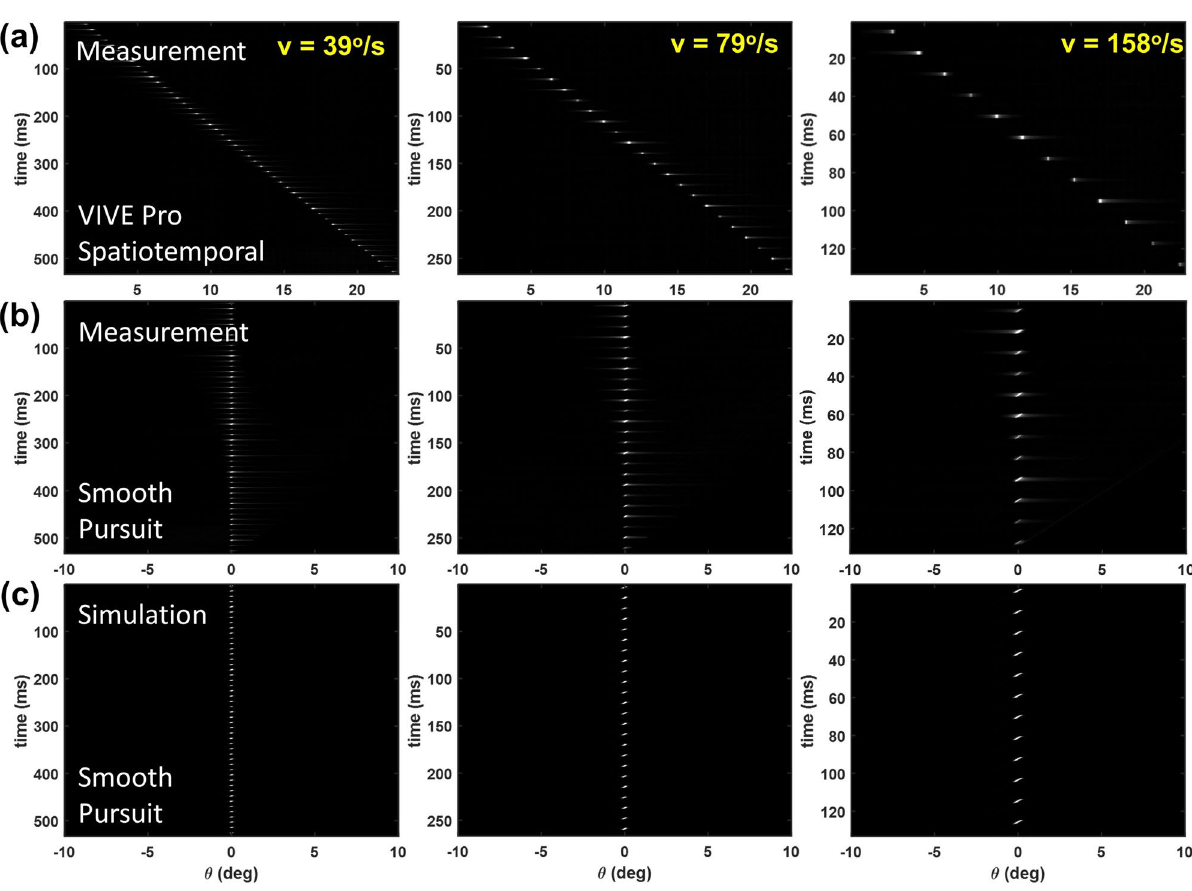
camera captured N images per display frame. For example, for the VIVE and VIVE Pro with a 90 Hz refresh rate, N is the division of camera frame rate over the VR display refresh rate, i.e., N = 1080 / 90 = 12 . The LSF of the moving line in each captured image was obtained by averaging over 100 central rows (see the right half of Fig. 3). Note that the white line is static within each display frame, while laterally shifted by v / f degrees between neighboring display frames, where f is the display refresh rate. Also shown in Fig. 3, within each display frame of the VIVE Pro, the emission is only on for a short period of time (approximately 2 frames/12 frames ≈ 17%).